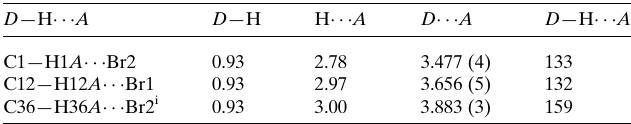
Table 1 Selected geometric parameters (A˚ , (cid:4) ).